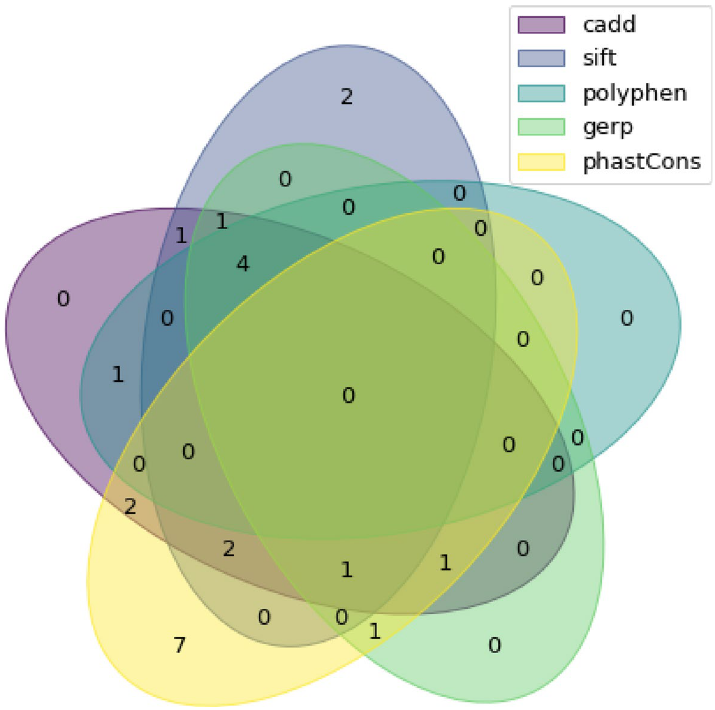
Figure 1. Venn diagram of included variants from RNA-seq for each bioinformatic filter.